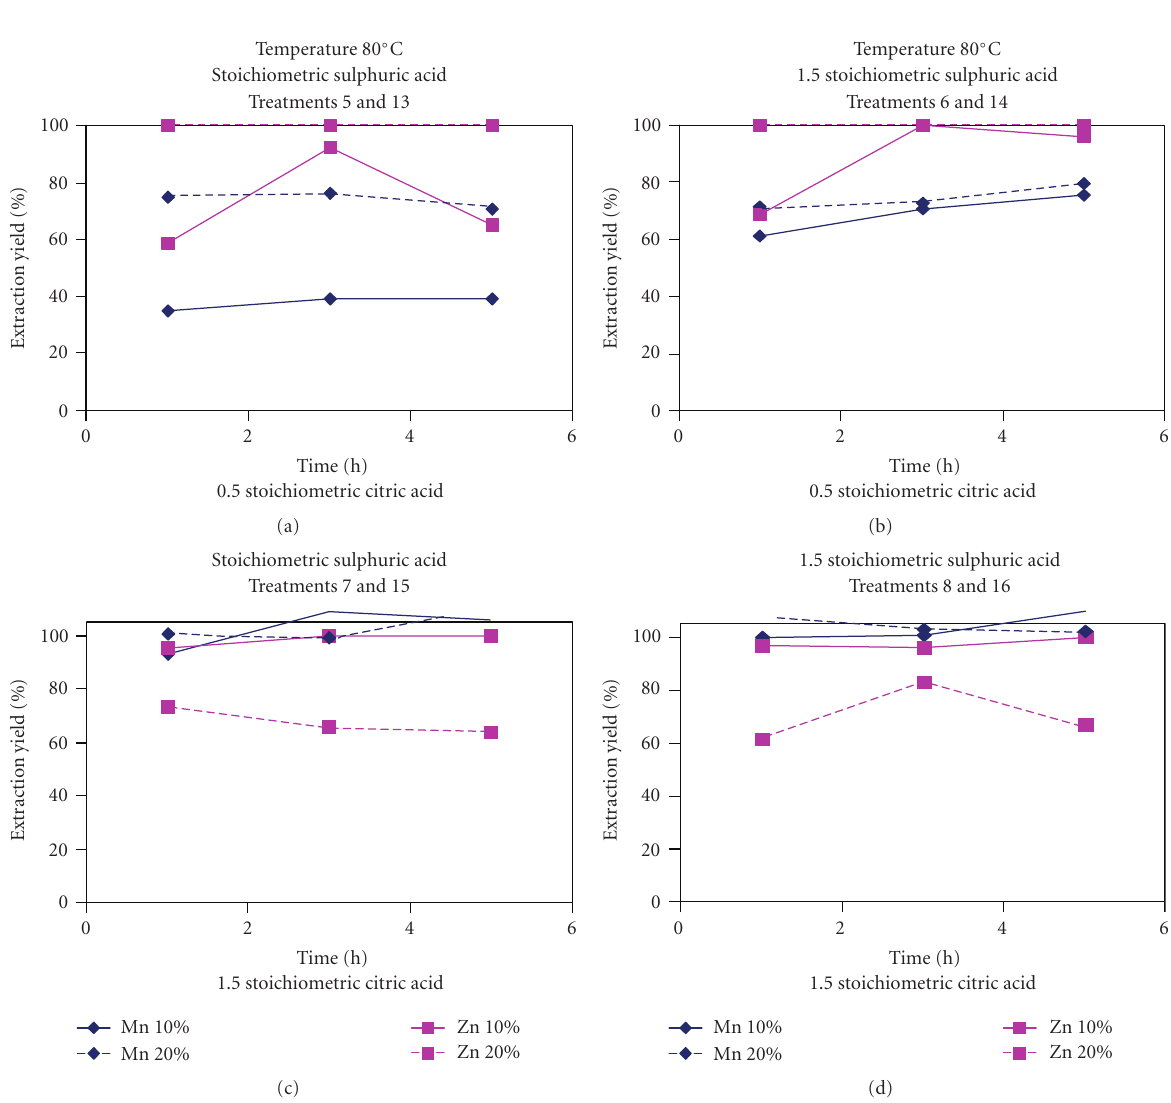
Figure 3: Zinc and manganese extraction yields versus time profiles during exhaust battery powder leaching by sulphuric acid solution in the presence of citric acid as reducing agent (temperature 80 ◦ C). See Table 1 for experimental conditions (continuous lines are related to treatments with 10% powder, dotted lines to treatments with 20%